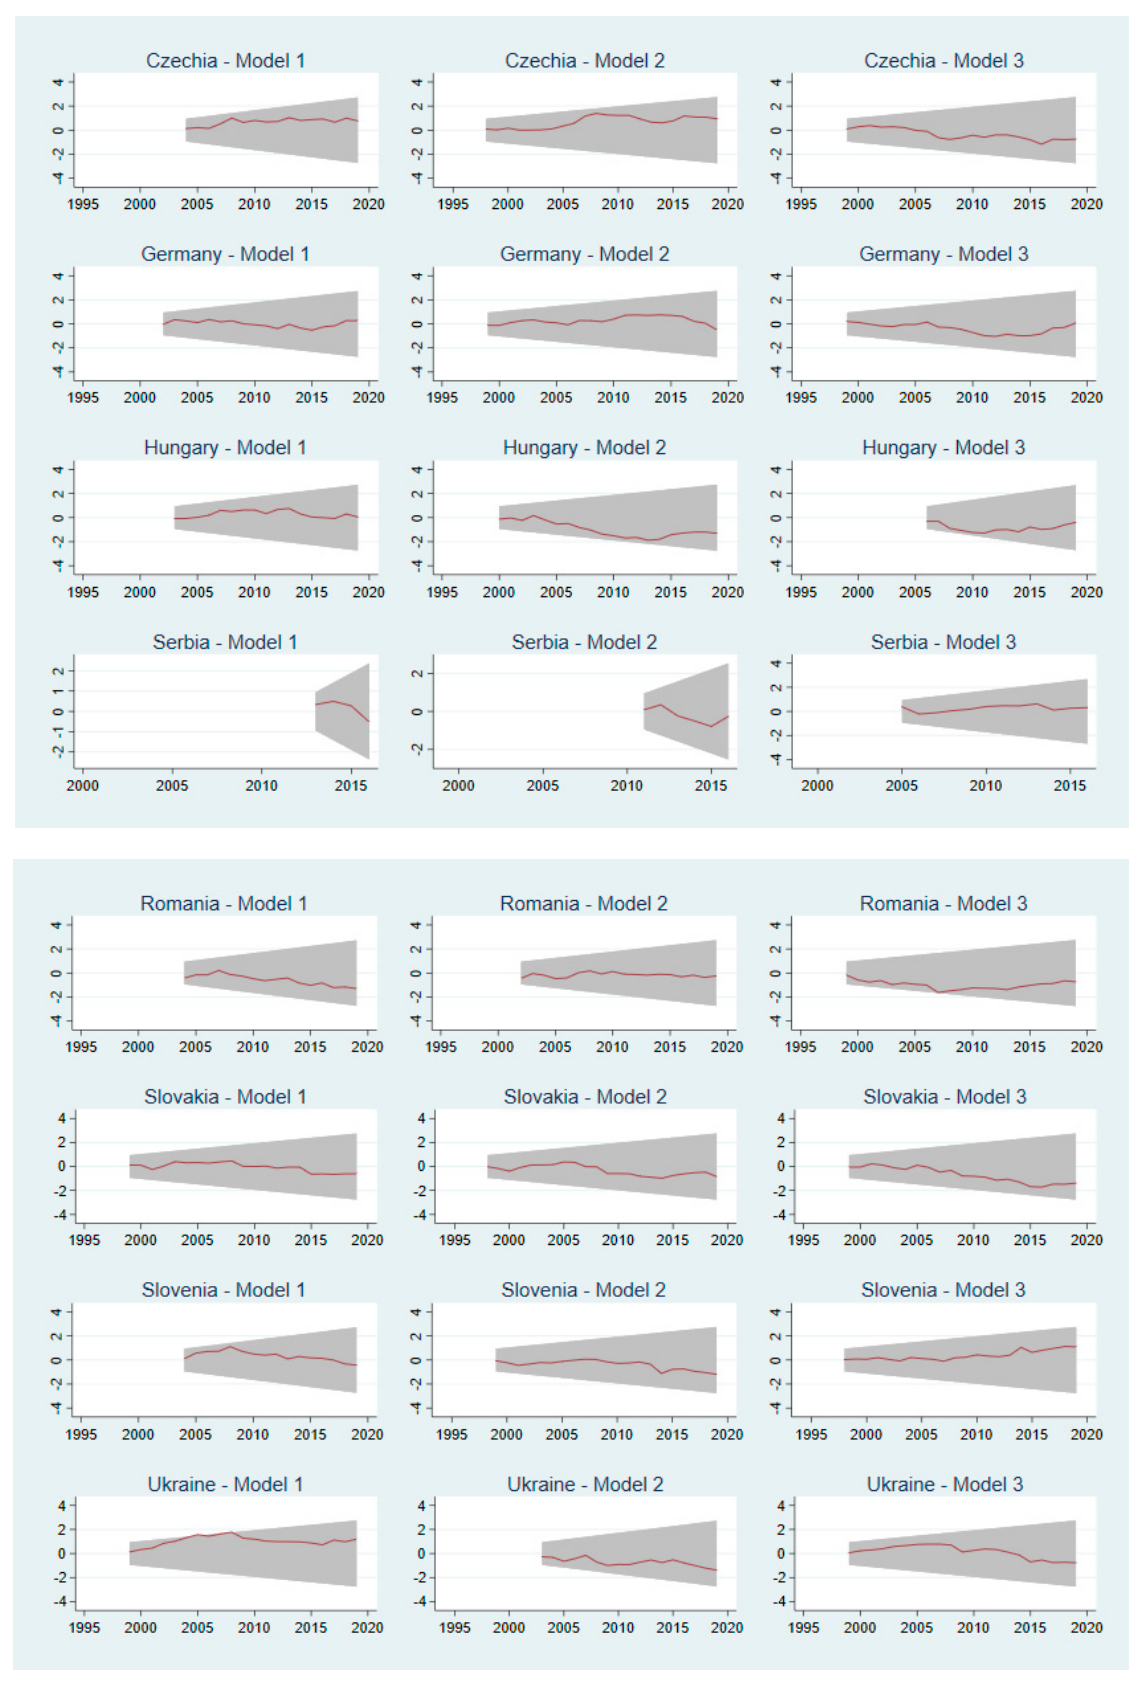
Figure A1. The cumulative sum of recursive residuals (CUSUM) plots.